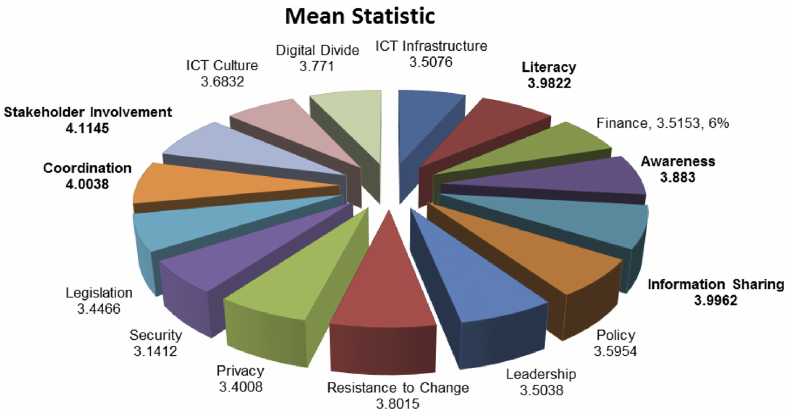
Figure 6. Summary of finding and data